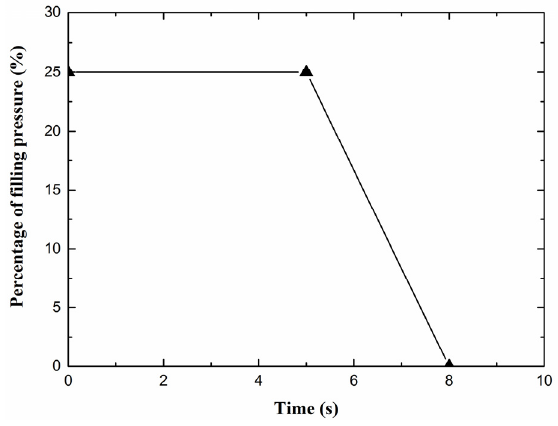
Figure 4. Packing process curve in this study. Table 2. Recommended process parameters for ABS (Lustran PG 298).